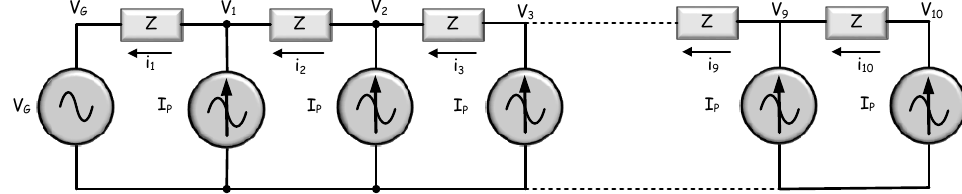
Figure 2. Equivalent circuit of a massive connection of photovoltaic systems.